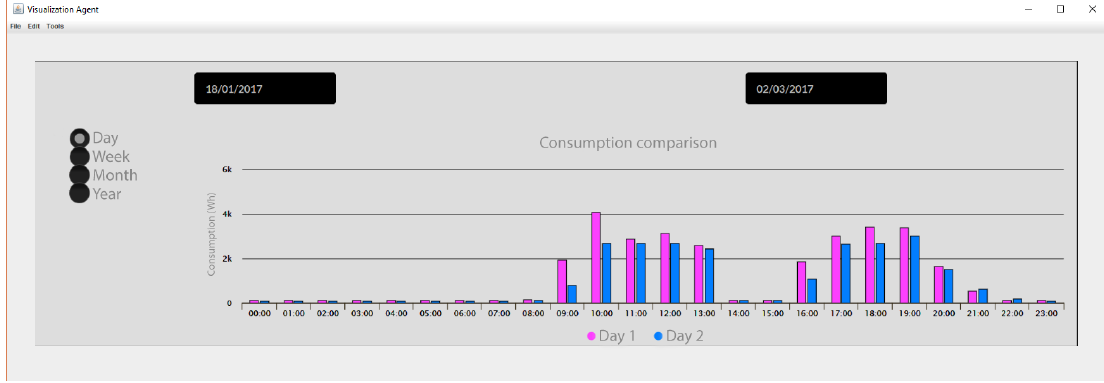
Figure 18. Details about consumption, invoice, CO 2 production on a specific day.